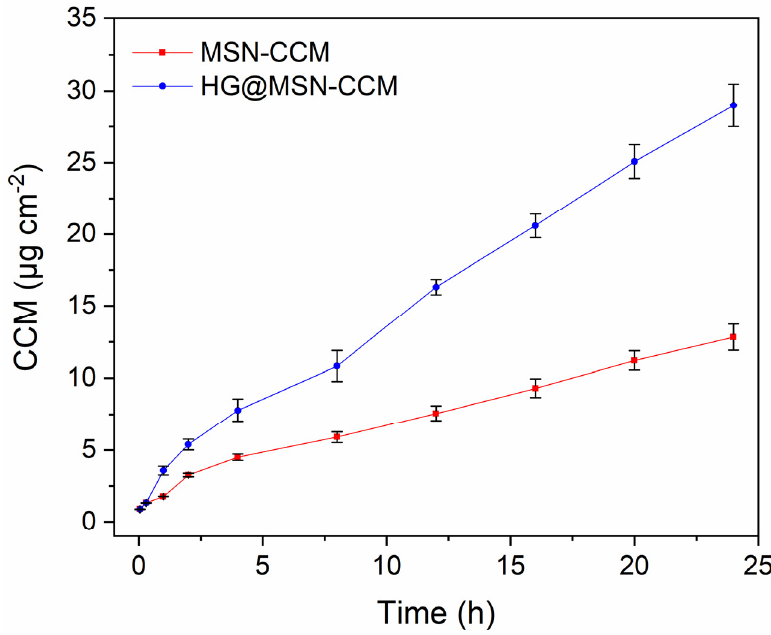
Figure 8. Ex vivo permeation profiles of the CCM from MSN-CCM and HG@MSN-CCM. Profiles are presented as mean ± SD; n = 5.